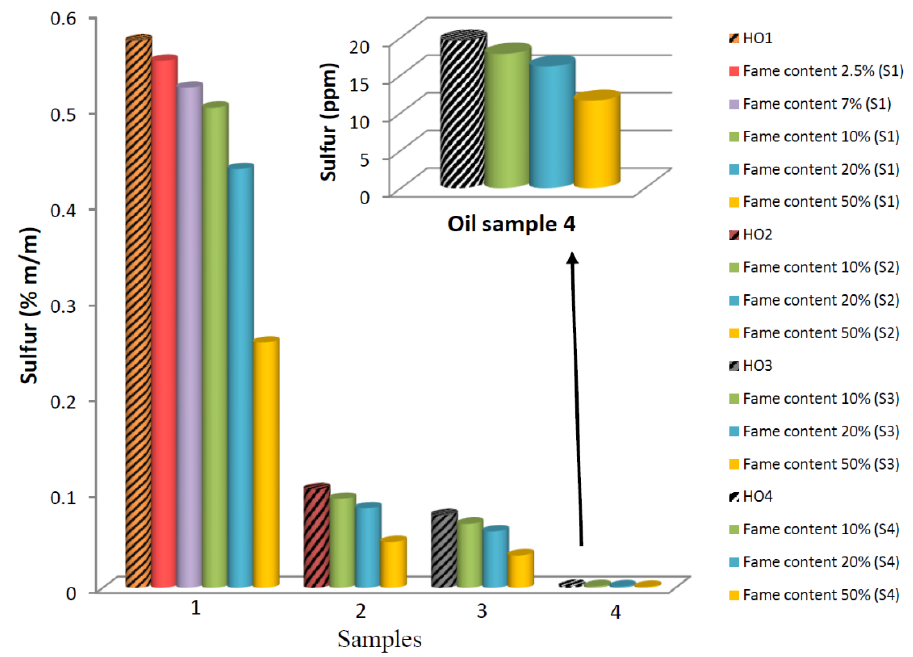
Figure 1. Sulfur content of oil samples. HO1: heating oil with destination outside Europe, HO2: heating oil with destination within Europe, HO3: heating oil for Cyprus trade and HO4: rural Cyprus oil.